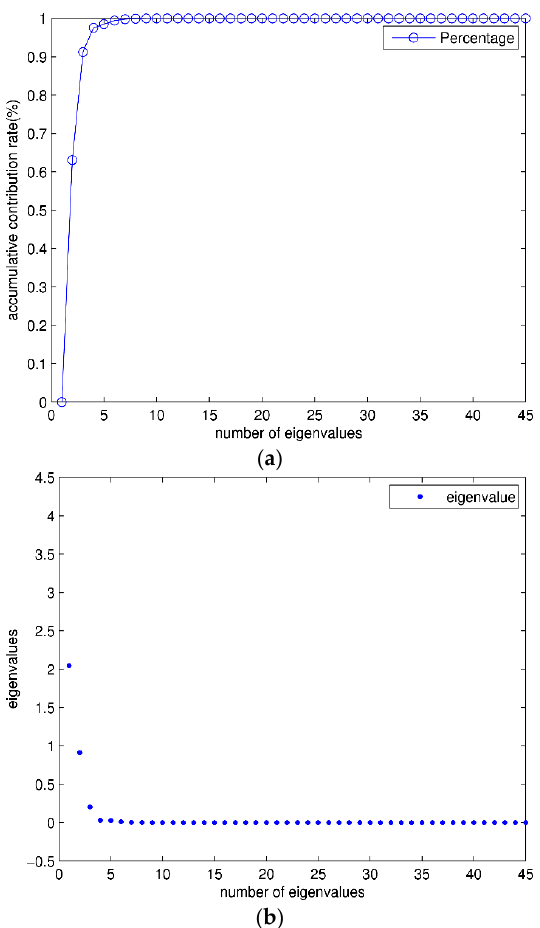
Figure 6. Eigenvalues: ( a ) The percentage of eigenvalues, the percentage of eigenvalues can be calculated by accumulation; ( b ) The eigenvalues of contribution matrix. The “·” represents each eigenvalues.